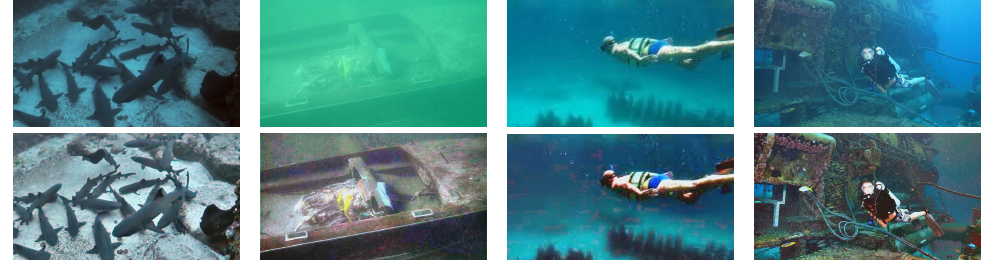
Figure 9. Some color distortion examples from the UIEB dataset. Top row: images with color casts; Bottom row: corresponding enhanced